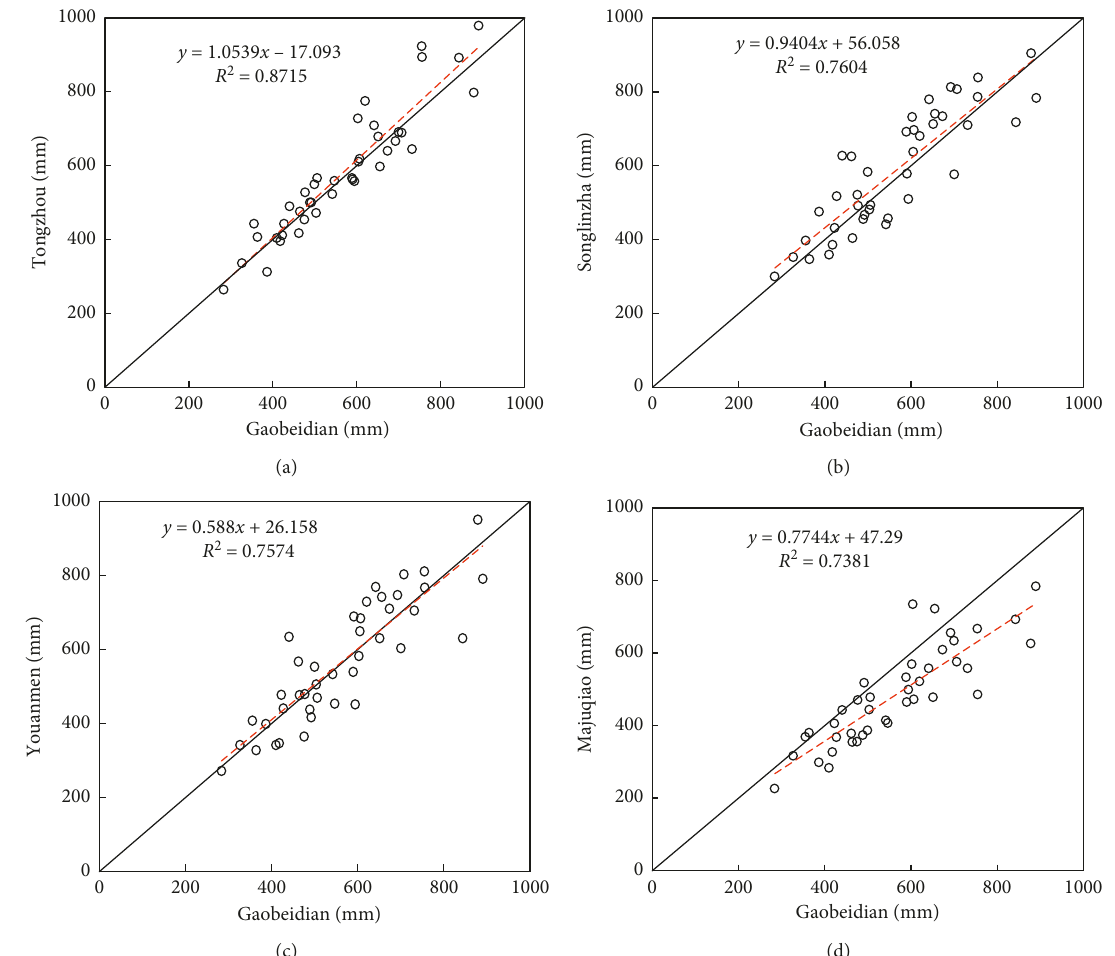
Figure 2: Scatter plots for the correlation relationship between Gaobeidian station and surrounding rain gauges. The black solid lines are 1: 1 lines. The red dashed lines mean the linear regression